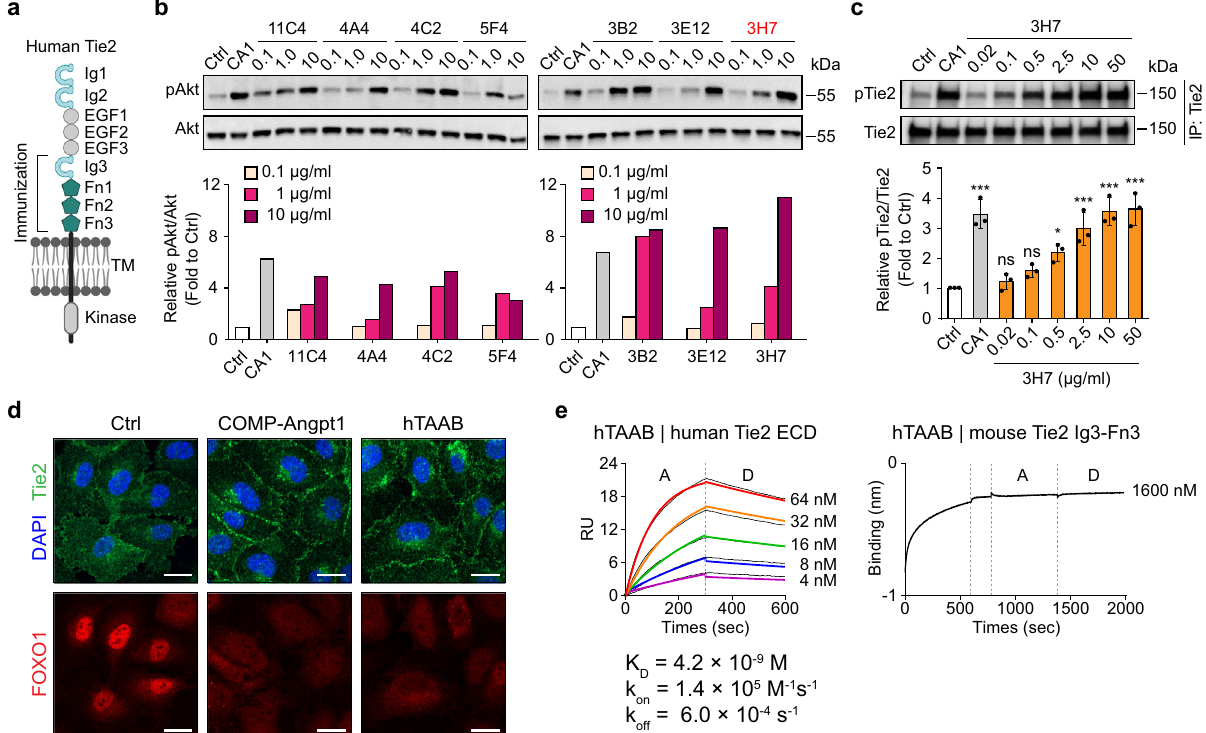
Fig. 1 Generation of a Tie2-activating mouse monoclonal antibody. a Schematic of the domain structure of the Tie2 receptor. Ig immunoglobulin-like domain, EGF epidermal growth factor-like domain, Fn fi bronectin type III domain. b Immunoblot detection of Tie2 downstream signaling (Akt and p-Akt) in HUVECs stimulated with each of seven puri fi ed Tie2-activating antibodies (11C4, 4A4, 4C2, 5F4, 3B2, 3E12, and 3H7; 0.1, 1, and 10 μ g/ml) for 30 min. The selected 3H7 clone is colored in red. No treatment for negative control (Ctrl) and COMP-Angpt1 (CA1, 1 μ g/ml) for positive control. c Concentration- dependent Tie2 phosphorylation upon treatment of HUVECs with 3H7 (0.02, 0.1, 0.5, 2.5, 10, 50 μ g/ml). Immunoblot (top) and densitometric analyses (bottom) of p-Tie2/Tie2 ratios are shown. Data from three independent experiments ( n = 3) were analyzed and expressed as mean ± SD (* P = 0.0104, *** P < 0.001 vs. control). P values by one-way ANOVA test followed by Dunnett ’ s multiple comparisons test. ns, not signi fi cant. d Representative confocal images of HUVECs showing hTAAB-induced Tie2 translocation to cell – cell contacts (top) and hTAAB-induced nuclear clearance of FOXO1 (bottom). Serum-starved HUVECs were treated with hTAAB (10 μ g/ml) or COMP-Angpt1 (1 μ g/ml) for 30 min. Goat anti-human Tie2 and Alexa Fluor 488- conjugated donkey anti-goat antibodies were used for Tie2 visualization, and rabbit anti-FOXO1 and Alexa Fluor 594-conjugated donkey anti-rabbit antibodies were used for FOXO1 visualization. Scale bars, 20 μ m. DAPI, 4 ’ , 6-diamidino-2-phenylindole. Similar results were observed in three independent experiments. e Binding kinetics of hTAAB for human (left) or mouse (right) Tie2 determined by SPR and BLI analysis, respectively. The equilibrium dissociation constant ( K D , M) was calculated as the ratio of off-rate to on-rate ( k off / k on ). Kinetic parameters were determined with the global fi tting function of Biacore Insight Evaluation Software using a 1:1-binding